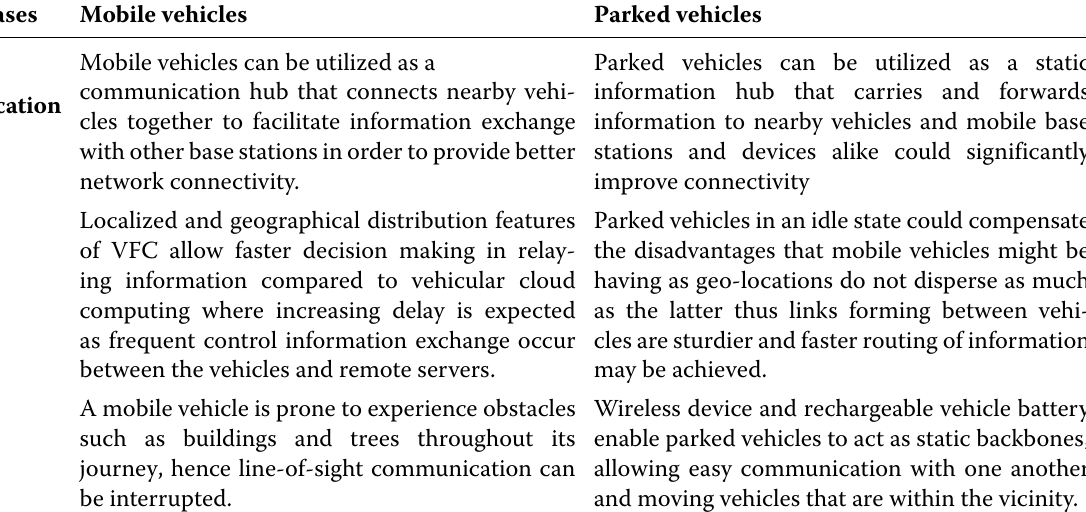
Table 1 Features of mobile and parked vehicles as a VFC infrastructures VFC use